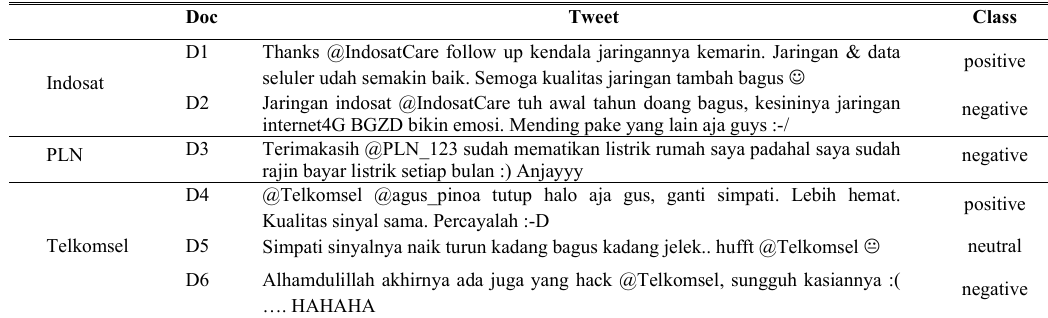
TABLE 1 E XAMPLE OF C RAWL T WEET R